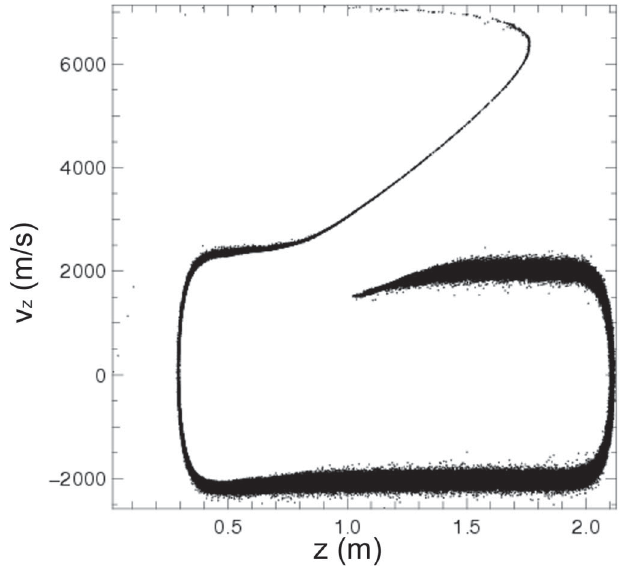
(cid:2) 52 : 2 kHz for q